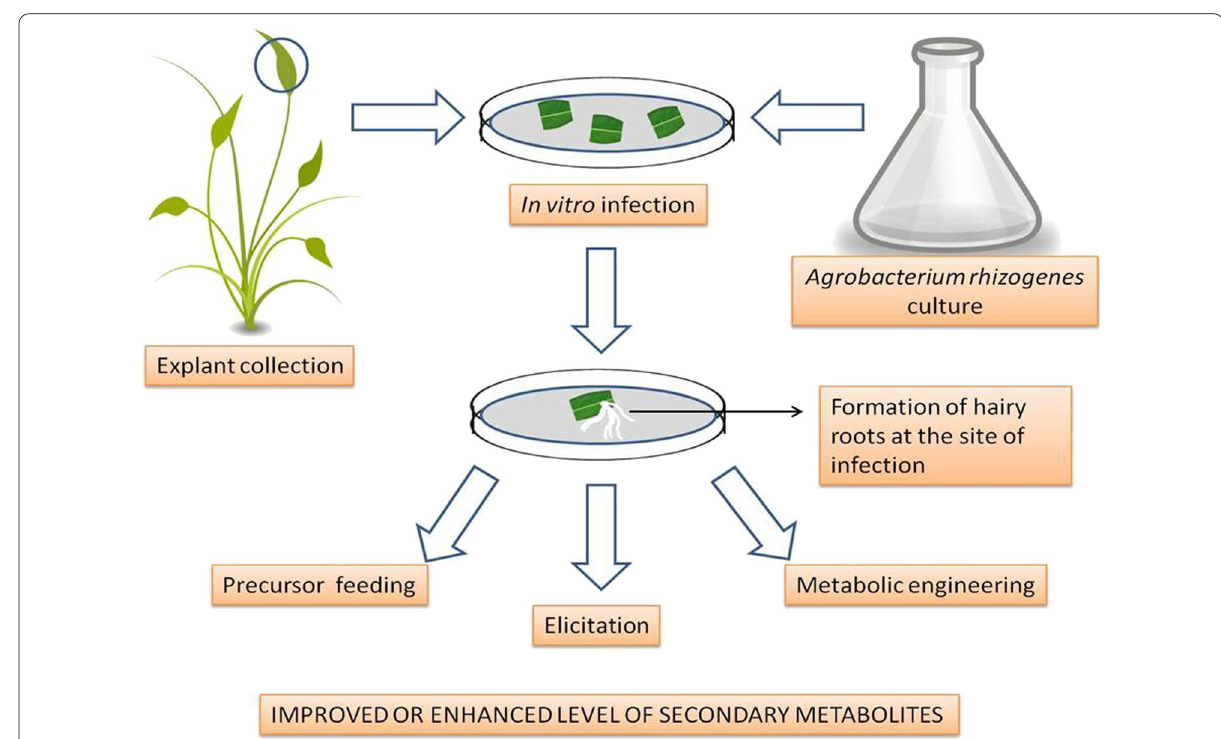
Fig. 4 Hairy root culture